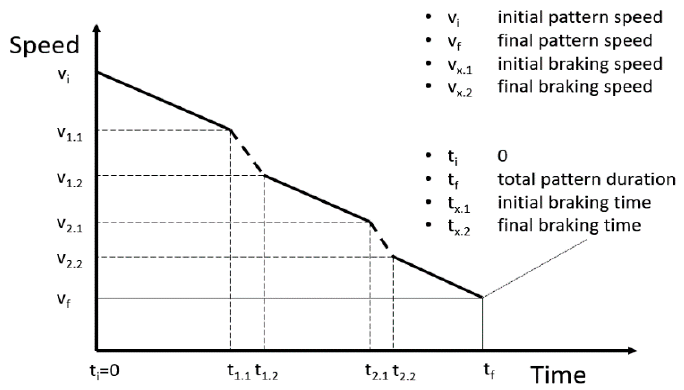
Figure 1. Pattern of Corrected Inertia without Stopping.